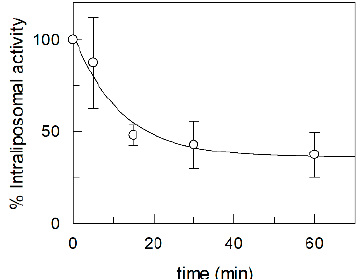
Figure 8. Efflux of riboflavin from proteoliposomes reconstituted with recombinant RFVT2. Proteoliposomes were incubated with [ 3 H]riboflavin for 60 min. After this incubation, the external radiolabeled substrate was removed. The export of riboflavin from proteoliposomes was stopped at the indicated times and the residual intraliposomal radioactivity was measured as described in the Material and Method section. The values are means ± SD from three experiments.